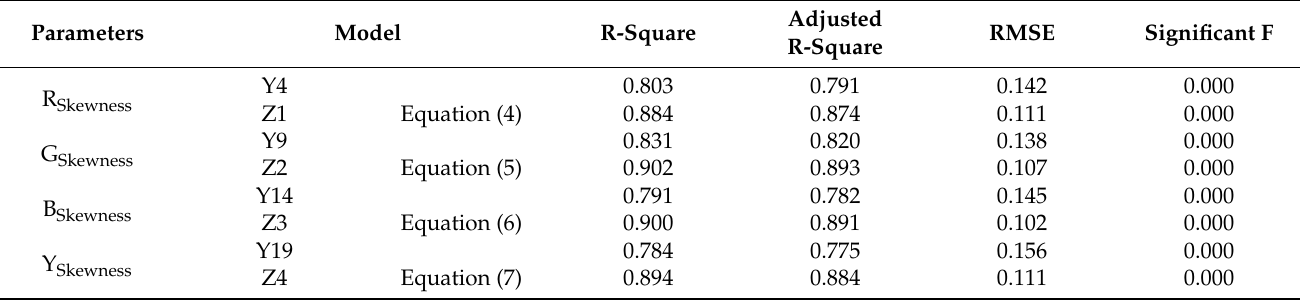
Table 5. Comparison of multiple stepwise regression models and spatial bidirectional models for the